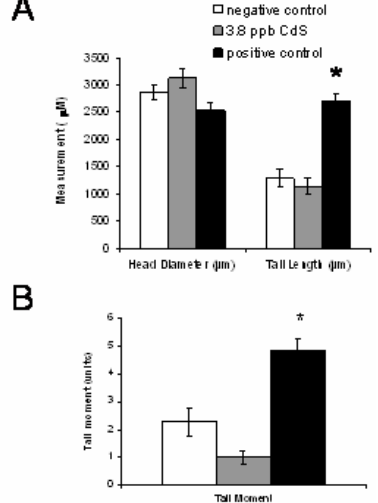
HeLa cells were treated with the cadmium dose (3.8